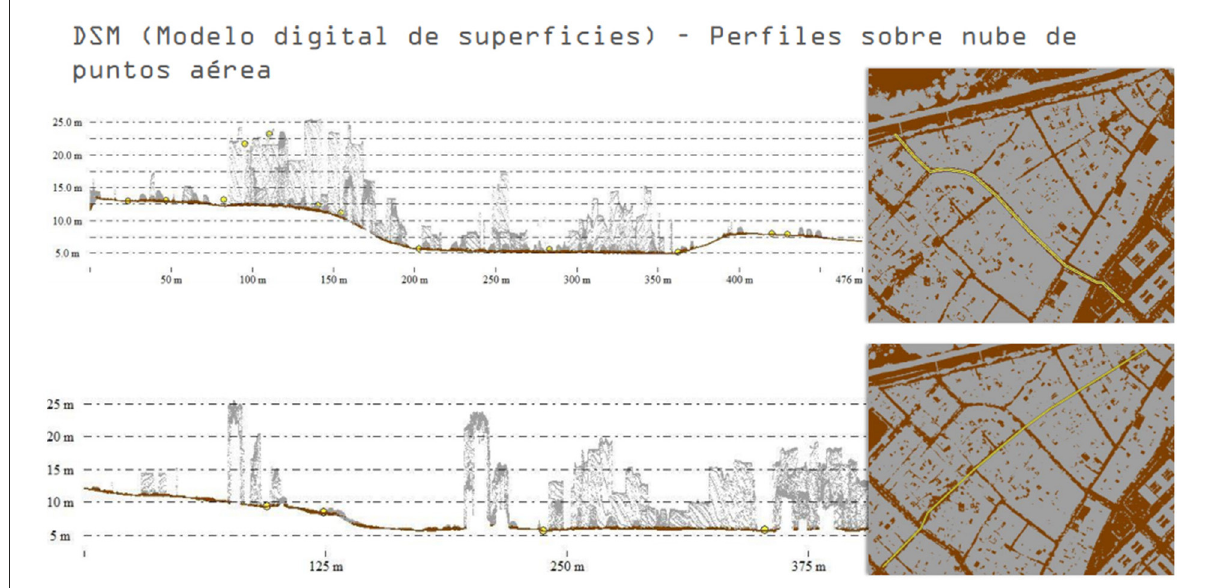
FIGURE2 Example of Geospatial information generated for Villa 20. Source: Office of Data Generation (Gerencia Operativa de Datos Territoriales), DG Urban Anthropology, SECDU,